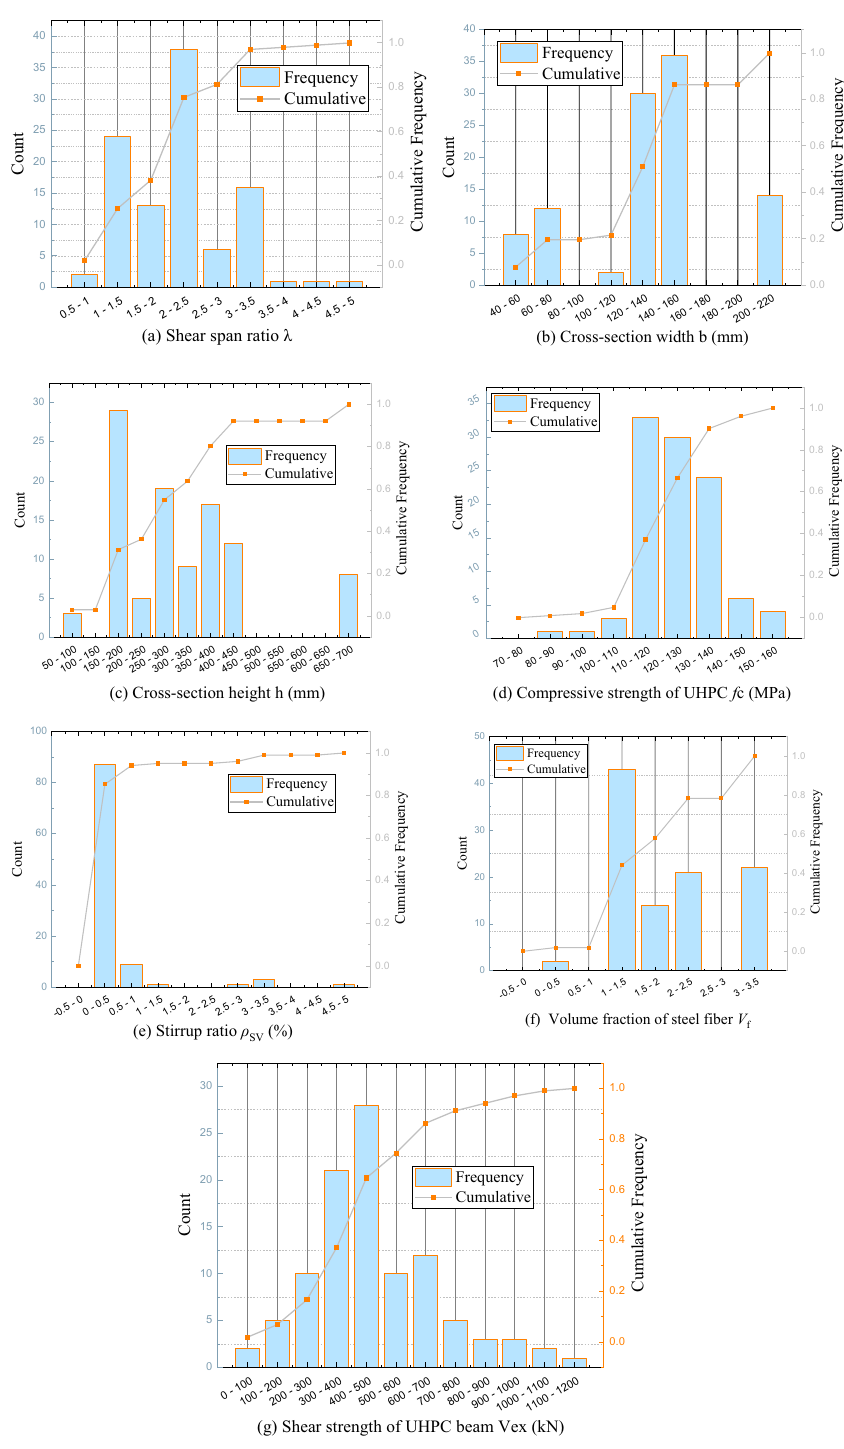
Figure 8. Variable frequency distribution